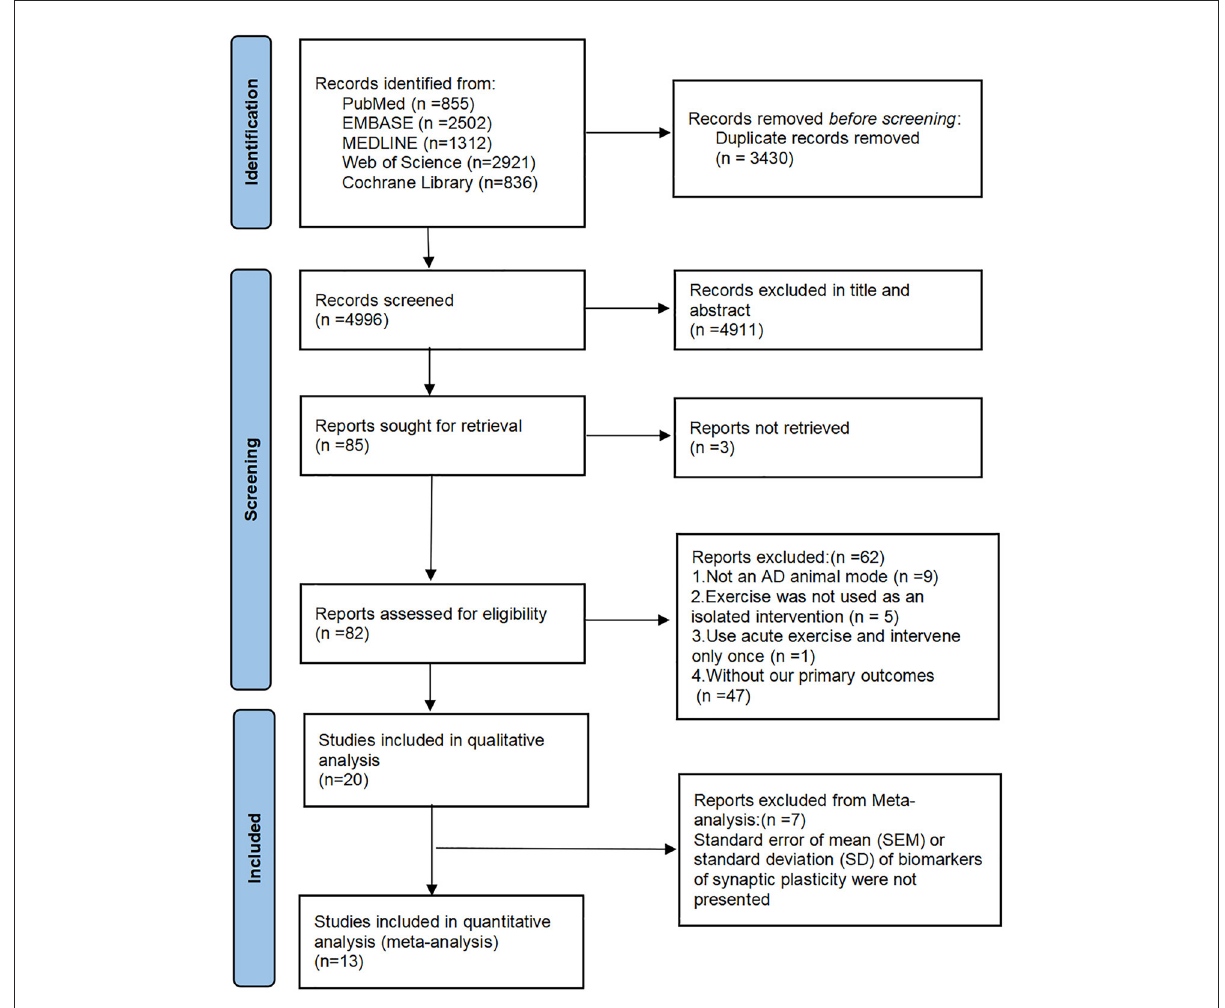
FIGURE1 The flow diagram of the study selection